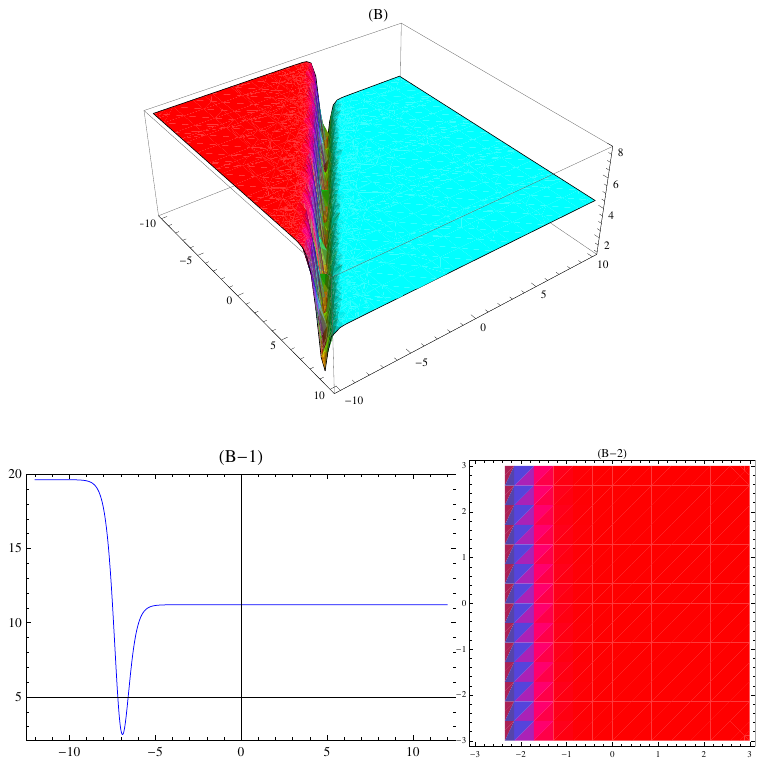
Figure 2: (B) 3D graph of (18) with α = 2.2 , 𝛾 = 1.6 , Θ = 2.3 , λ = 3.4 , µ = 3.7 , w = 2.2 , p = 0.98 , q = 0.95 , k = 2 , A = 2.4 , δ = −2 , ς = 1.9 , τ = 0.85 , c = 2.9 , z = 3 , χ = 1.5 , ϵ = 3 , y = 2.5 . (B-1) 2D plot of (18) with t = 1 . (B-2) Contour graph of (18).